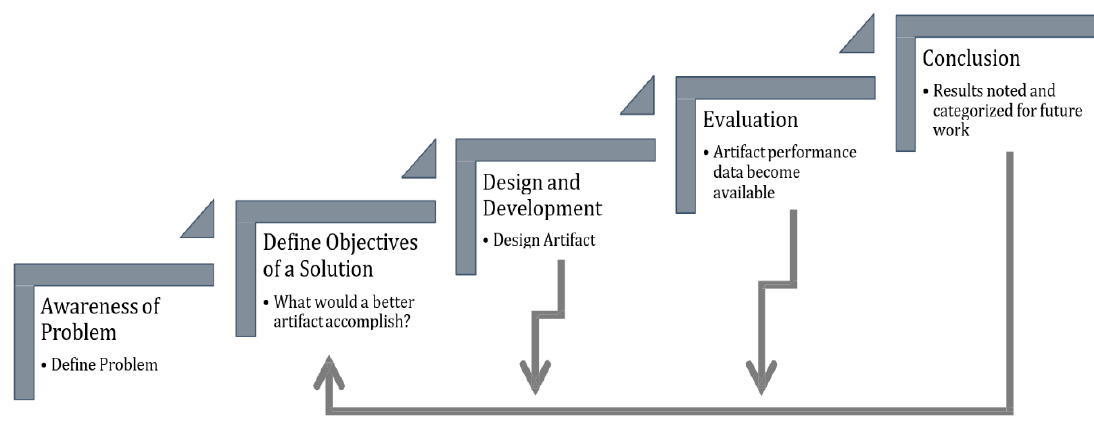
Figure 1. Design Science Research Process model based on Peffers et al. [14] and Kuechler & Vaishnavi [15].